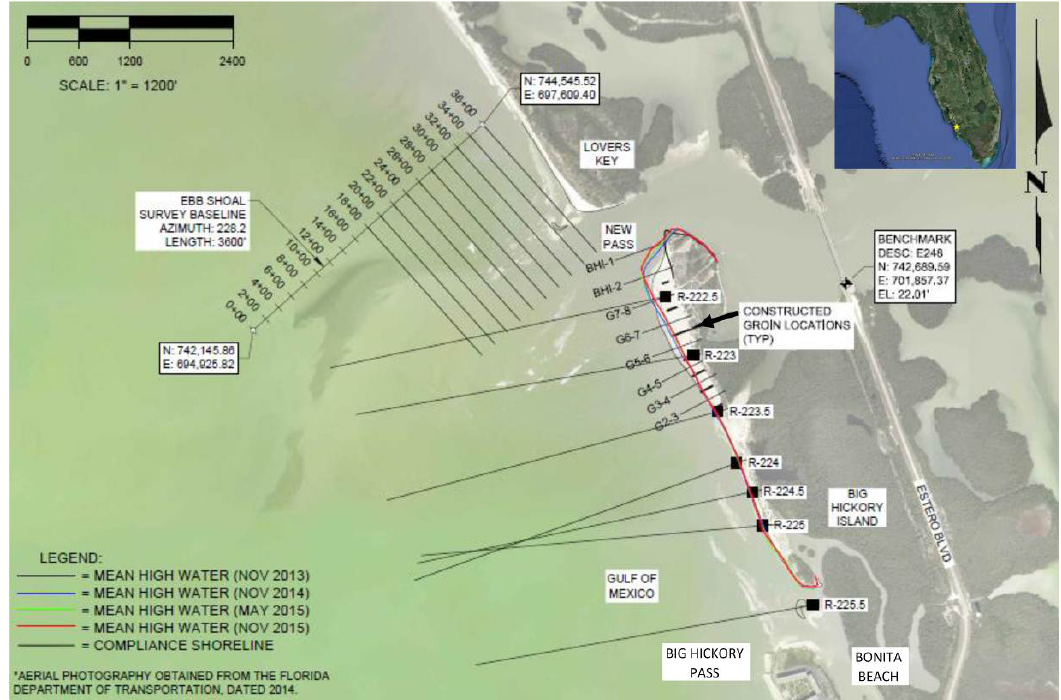
Figure 1. Big Hickory Island, FL survey plan with Google Earth image inset of Big Hickory Island location along the west Florida coast (yellow star).